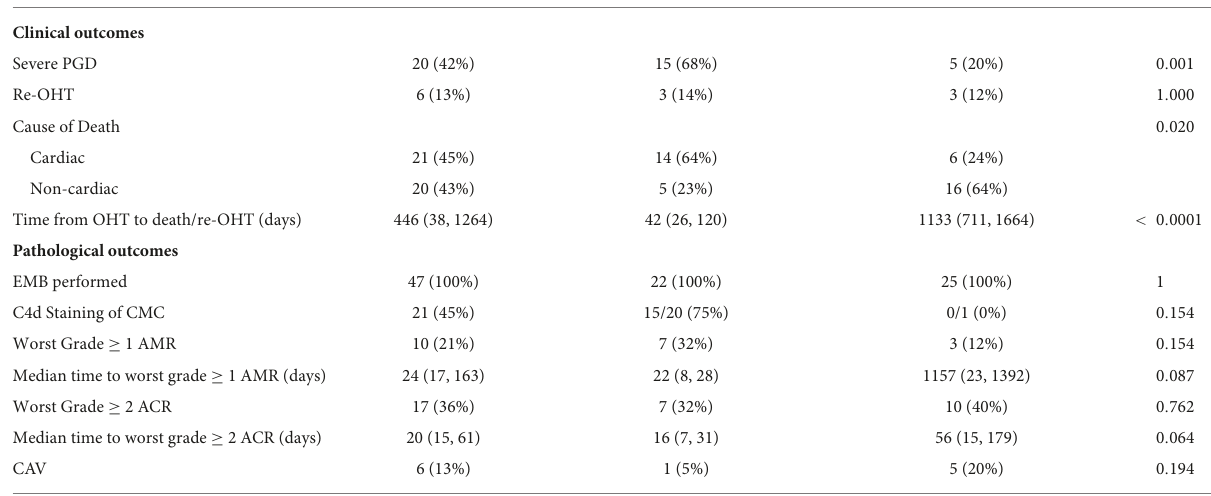
TABLE 2 Clinicopathological